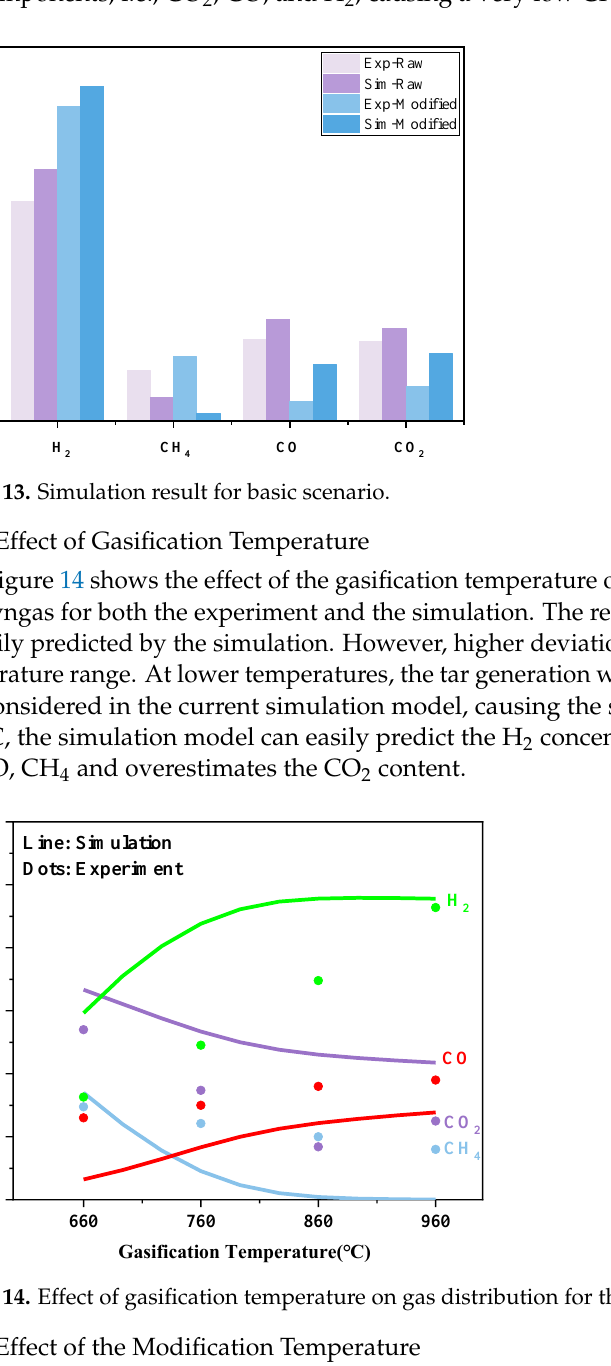
Figure 14. Effect of gasification temperature on gas distribution for the raw syngas.